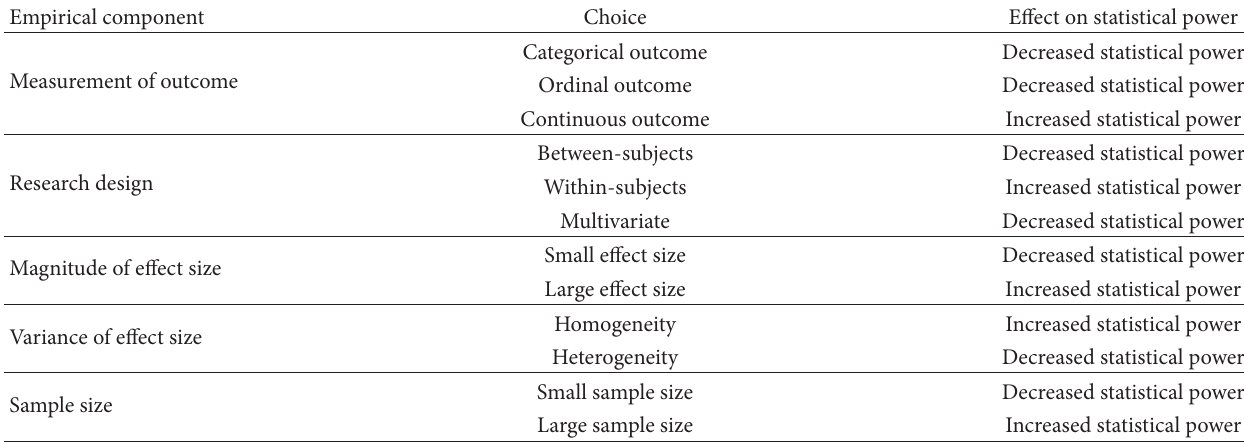
Table 1: Isomorphism and causal effects on statistical